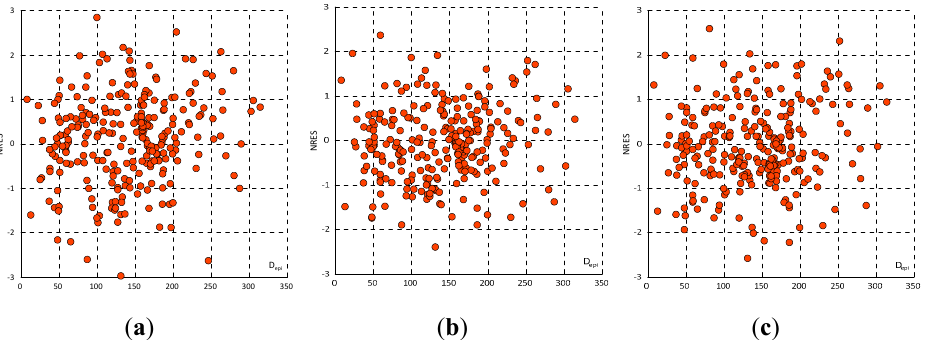
Figure 21. Distribution of normalized residuals with epicentral distance, set 3. ( a ) T = 0.30 s; ( b ) T = 1.00 s; ( c ) T = 1.50 s.